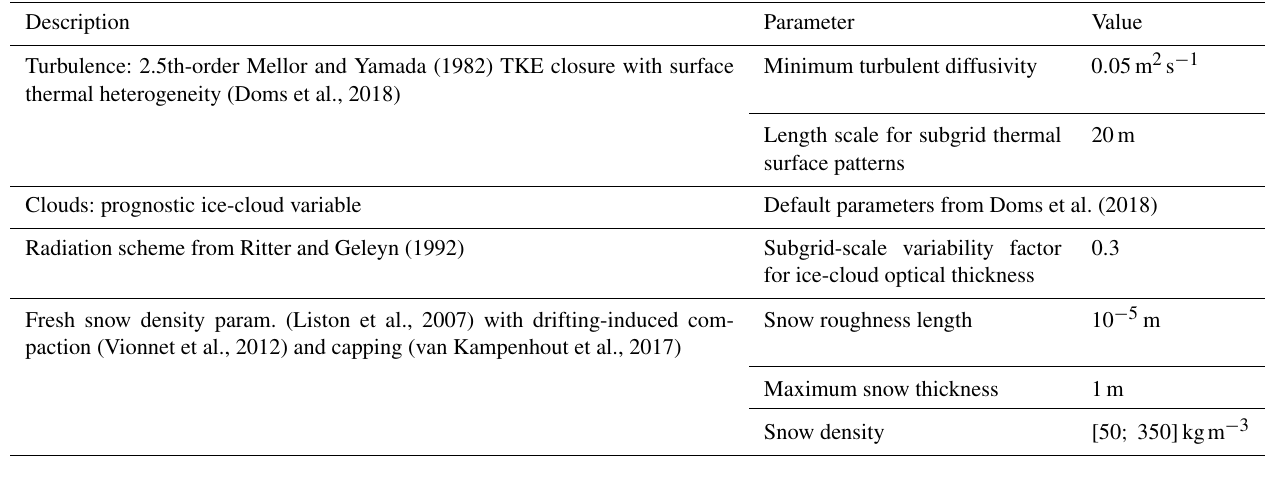
Table A2. List of key CCLM 2 parameterizations.